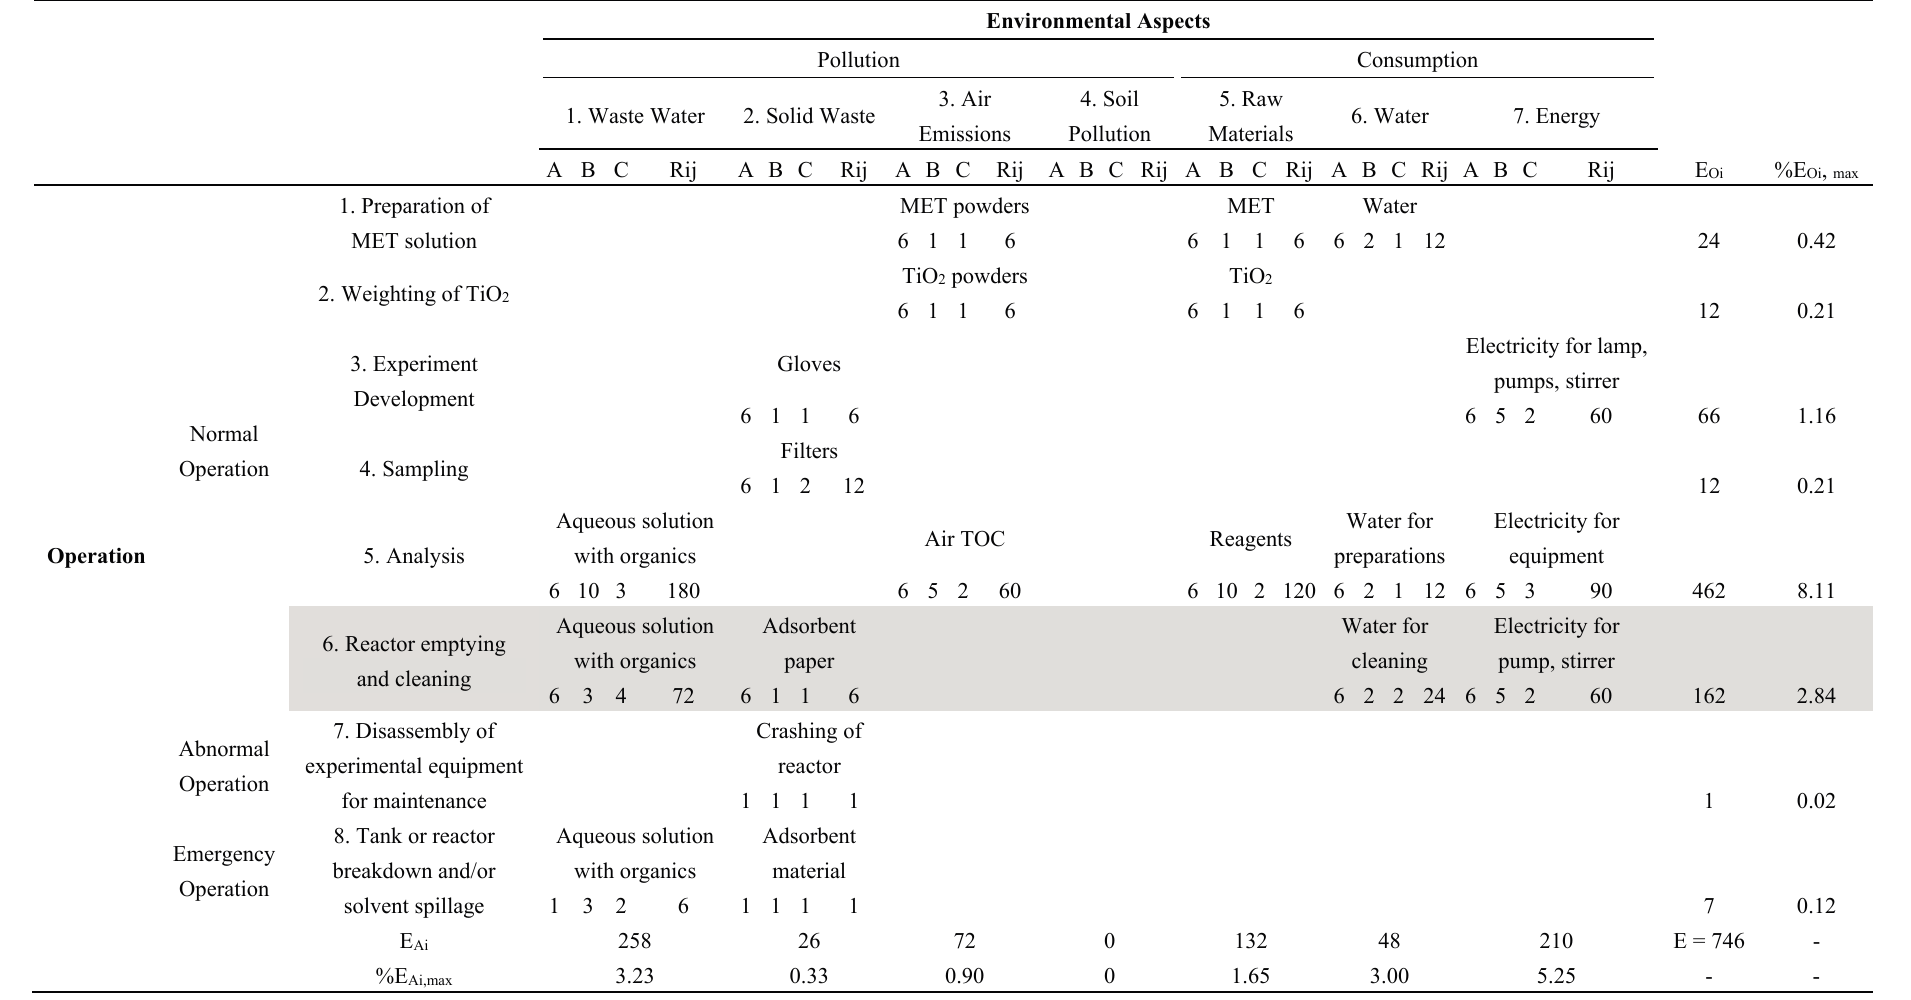
Table 1. Environmental Risk Identification and Evaluation. Process tested: MET treatment by photocatalysis with TiO 2 in the Solarbox. Parameters A–C are defined in Tables 2–4,